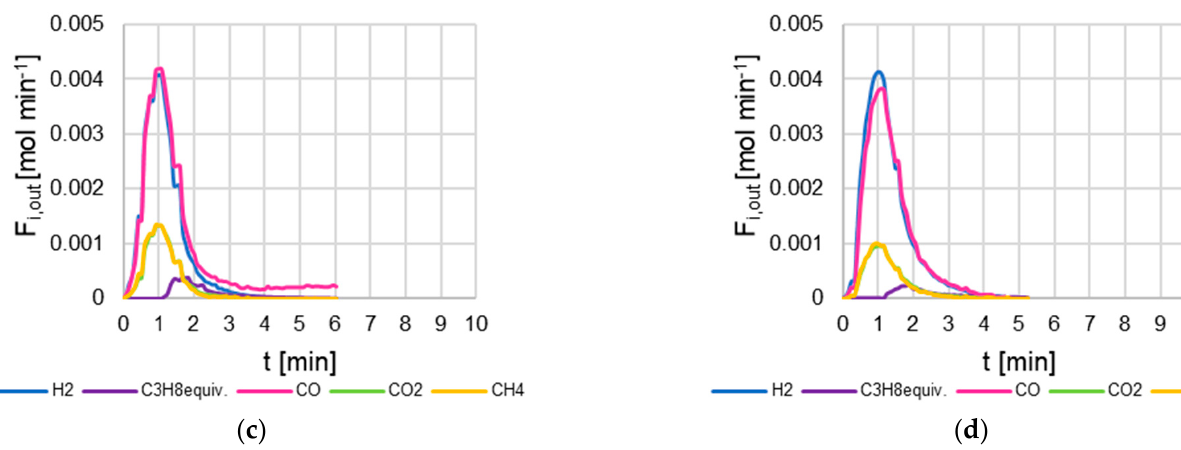
Figure 3 . Example of H 2 , CO, CO 2 , CH 4 and equivalent C 3 H 8 outlet molar flow rates (F i,out ) as functions of time ( t ), produced by devolatilizations of individual WSP pellets at 900 °C in beds made of sand ( a ), ILM ( b ), SIB ( c ) and LD ( d ).